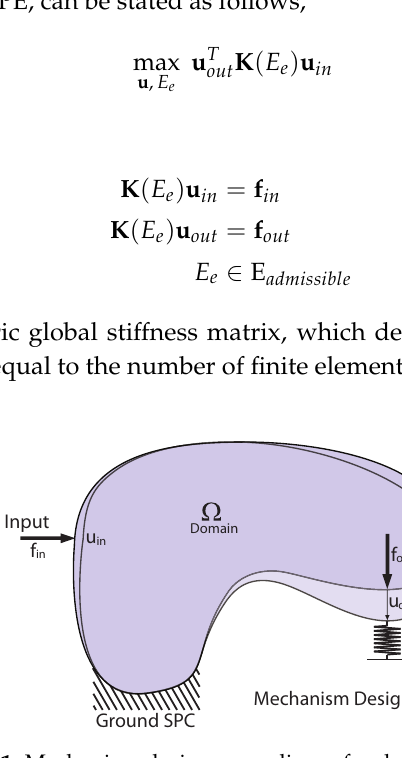
Figure 1. Mechanism design: compliance for desired